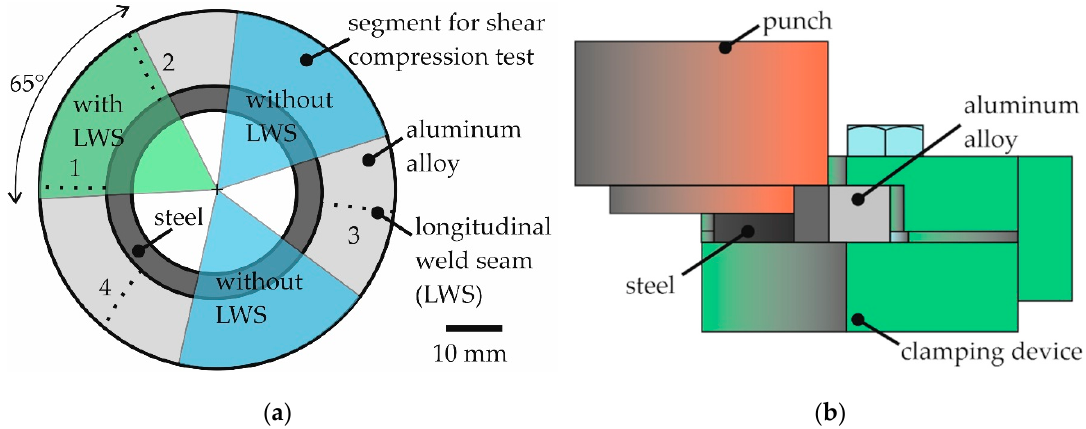
Figure 5. Schematic illustration of ( a ) sample segment extraction from the cross-section of a compound profile with one segment having two longitudinal weld seams (LWS, highlighted by dotted lines) at the edges and two segments each without weld seams, ( b ) test setup used for the shear compression test.